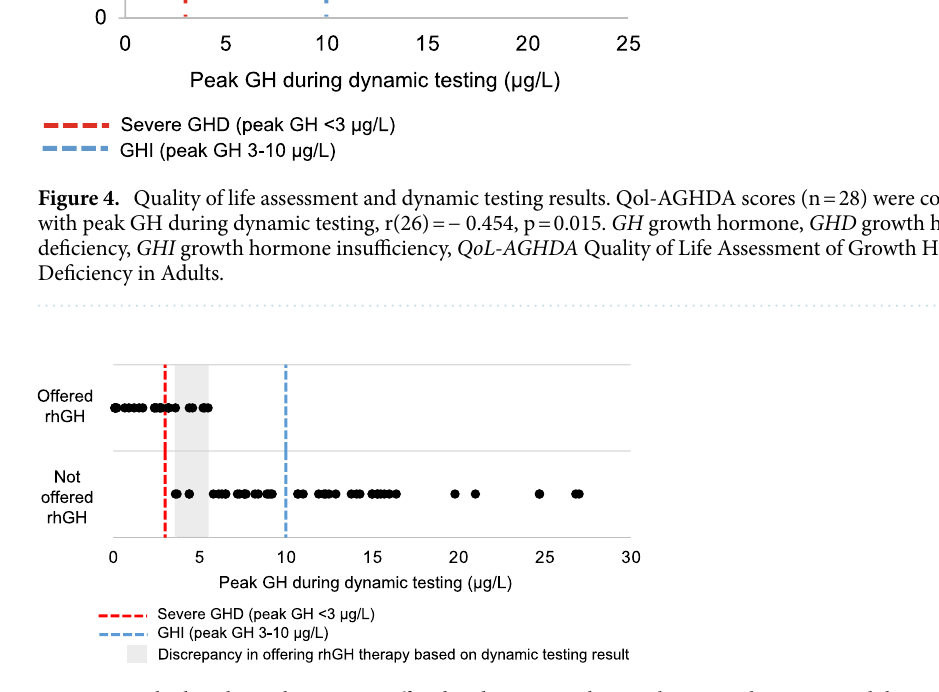
Figure 5. Whether rhGH therapy was offered and corresponding peak GH results. GH growth hormone, GHD growth hormone deficiency, GHI growth hormone insufficiency, rhGH recombinant human growth